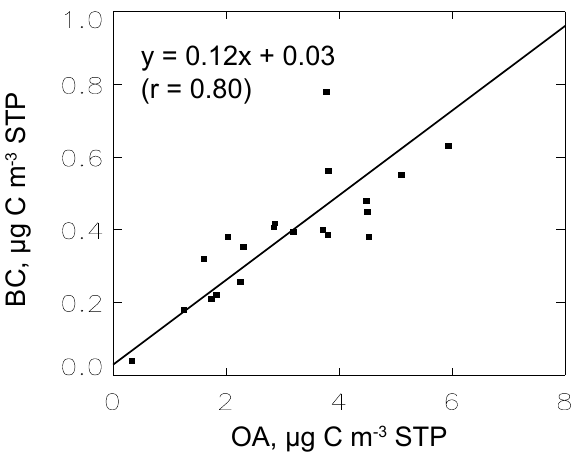
Fig. 2. Scatterplot of BC vs. OA concentrations in fire plumes diagnosed by [CH 3 CN] > 200ppt for the ensemble of ARCTAS DC-8 flights (1–19 April 2008). STP refers to standard conditions of temperature and pressure (273K, 1atm) so that µgCm − 3 STP is a mixing ratio unit. The reduced-major-axis (RMA) regression is shown by the solid line and the corresponding equation is given in the